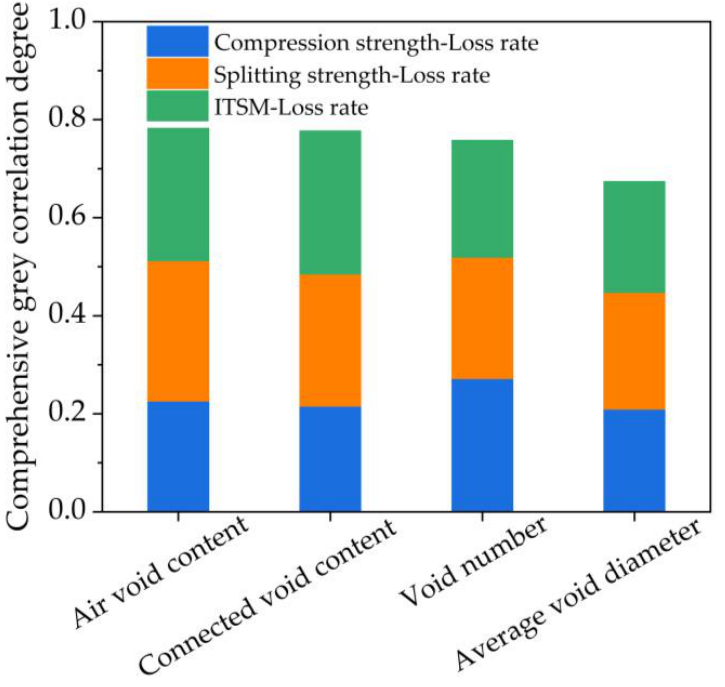
Figure 12. Comprehensive correlation between mechanical damage and meso characteristics of asphalt mixture.